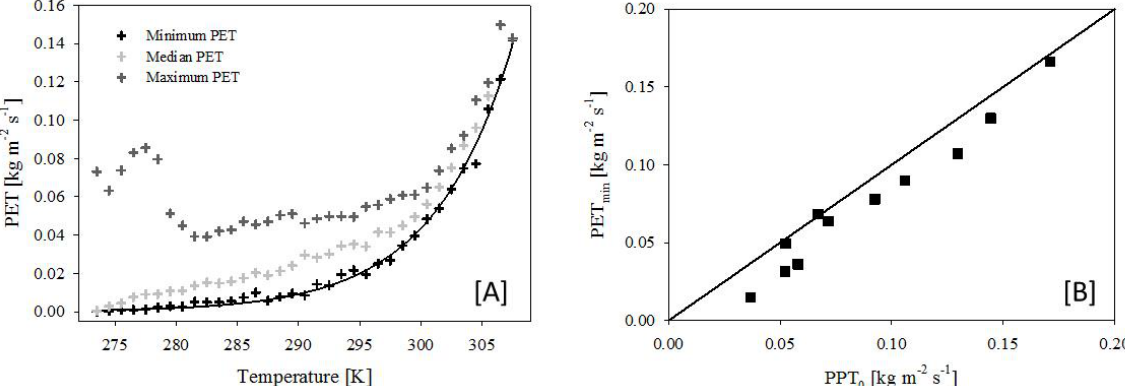
Fig. 6. The (a) maximum, median, and minimum potential evapotranspiration (PET) as determined using Thorthwaite-Mather (1957) relative to temperature, and (b) the mean minimum estimated potential evapotranspiration (PET min ) for one degree temperature bins relative to the precipitation threshold (PPT 0 ) required for effective energy and mass